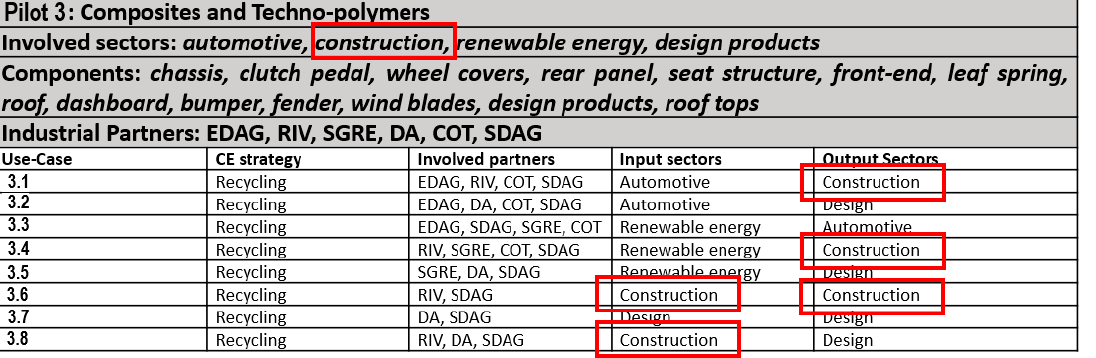
Figure 3. Pilot 3 use-cases.